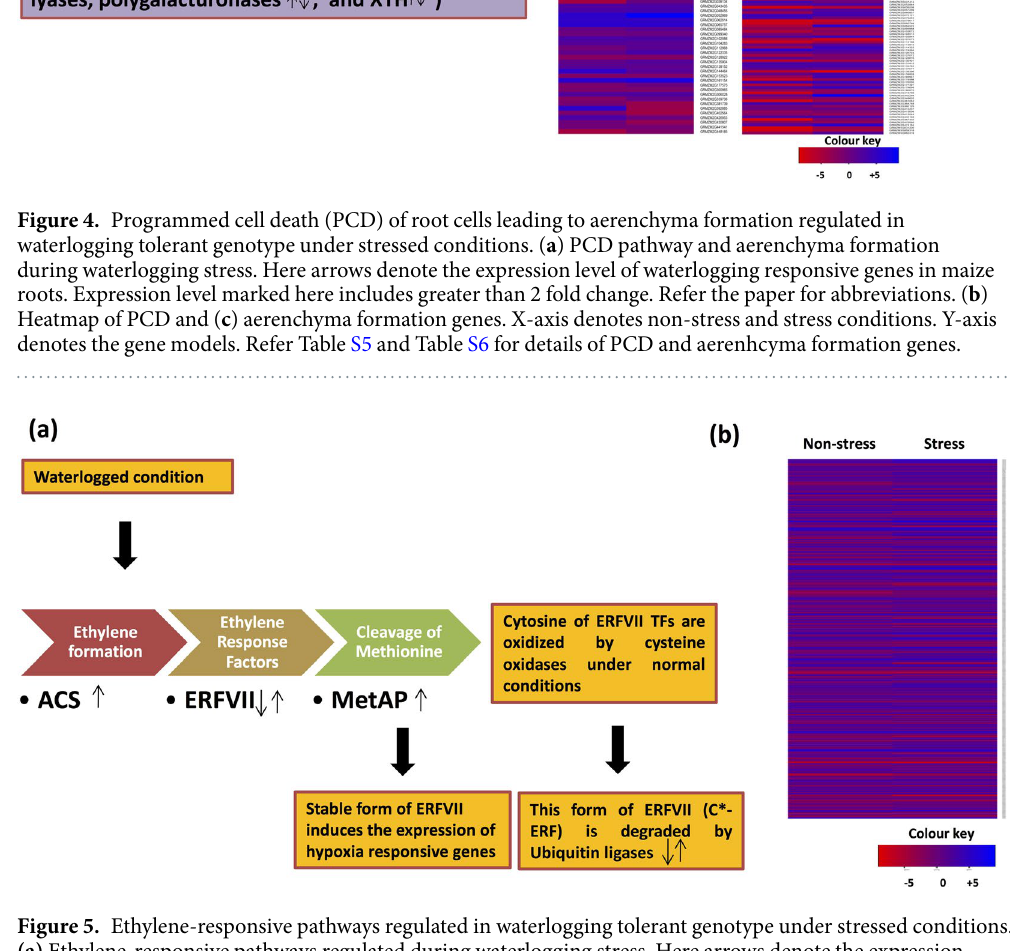
levels. However, varying forms of E3 Ubiquitin ligases and 26 S proteasomes were expressed in waterlogging conditions (Fig. 5) but since these enzymes also cleave non-stress proteins, so for investigating specific hypoxic responsive degradable enzymes mutant lines should be used to be tested upon.